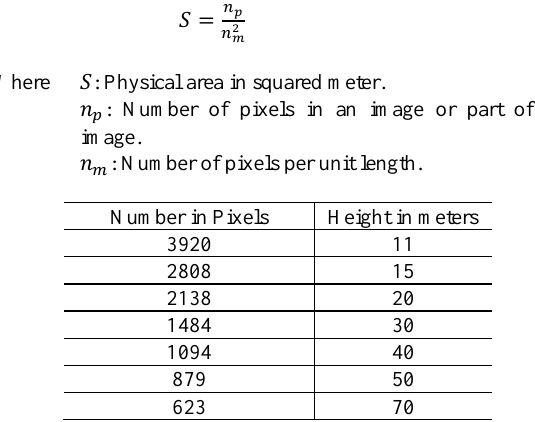
Table 1. Data used for experimental law derivation